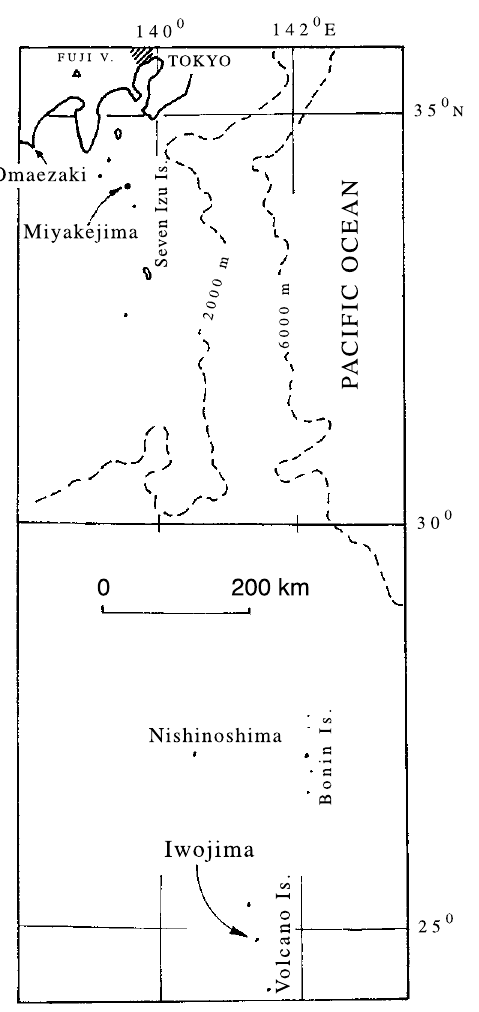
Fig. 5. Location map of Iwojima, Miyakejima and Cape Omaezaki.